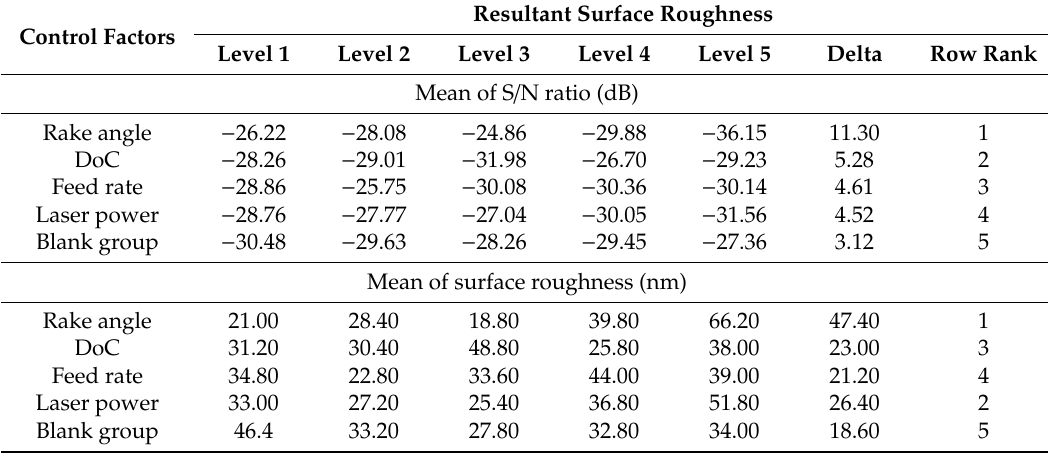
Table 5. Response table for mean surface